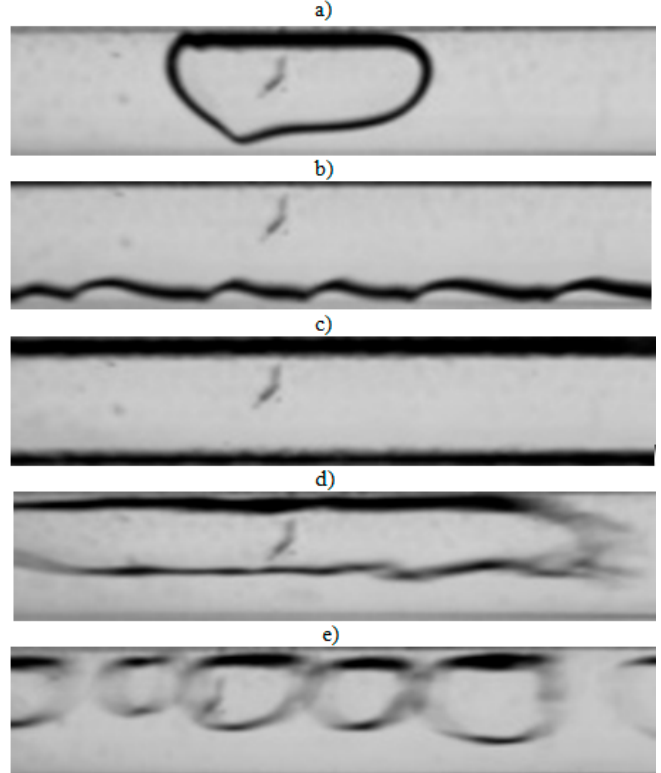
Figure 5. Experimental results of visualization research on HFE7000 refrigerant condensation in a minichannel with an internal diameter d h = 2.0 mm: ( a ) plug flow G = 88 kg/m 2 s, x = 0.002, ϕ = 0.27, t s = 29 °C; ( b ) annular ‐ wavy flow G = 97 kg/m 2 s, x = 0.011, ϕ = 0.68, t s = 31 °C; ( c ) annular flow G = 97 kg/m 2 s, x = 0.011, ϕ = 0.68, t s = 31 °C; ( d ) slug flow G = 1168 kg/m 2 s, x = 0.006, ϕ = 0.55, t s = 31 °C; ( e ) bubbly flow G = 487 kg/m 2 s, x = 0.003, ϕ = 0.26, t s = 41 °C.